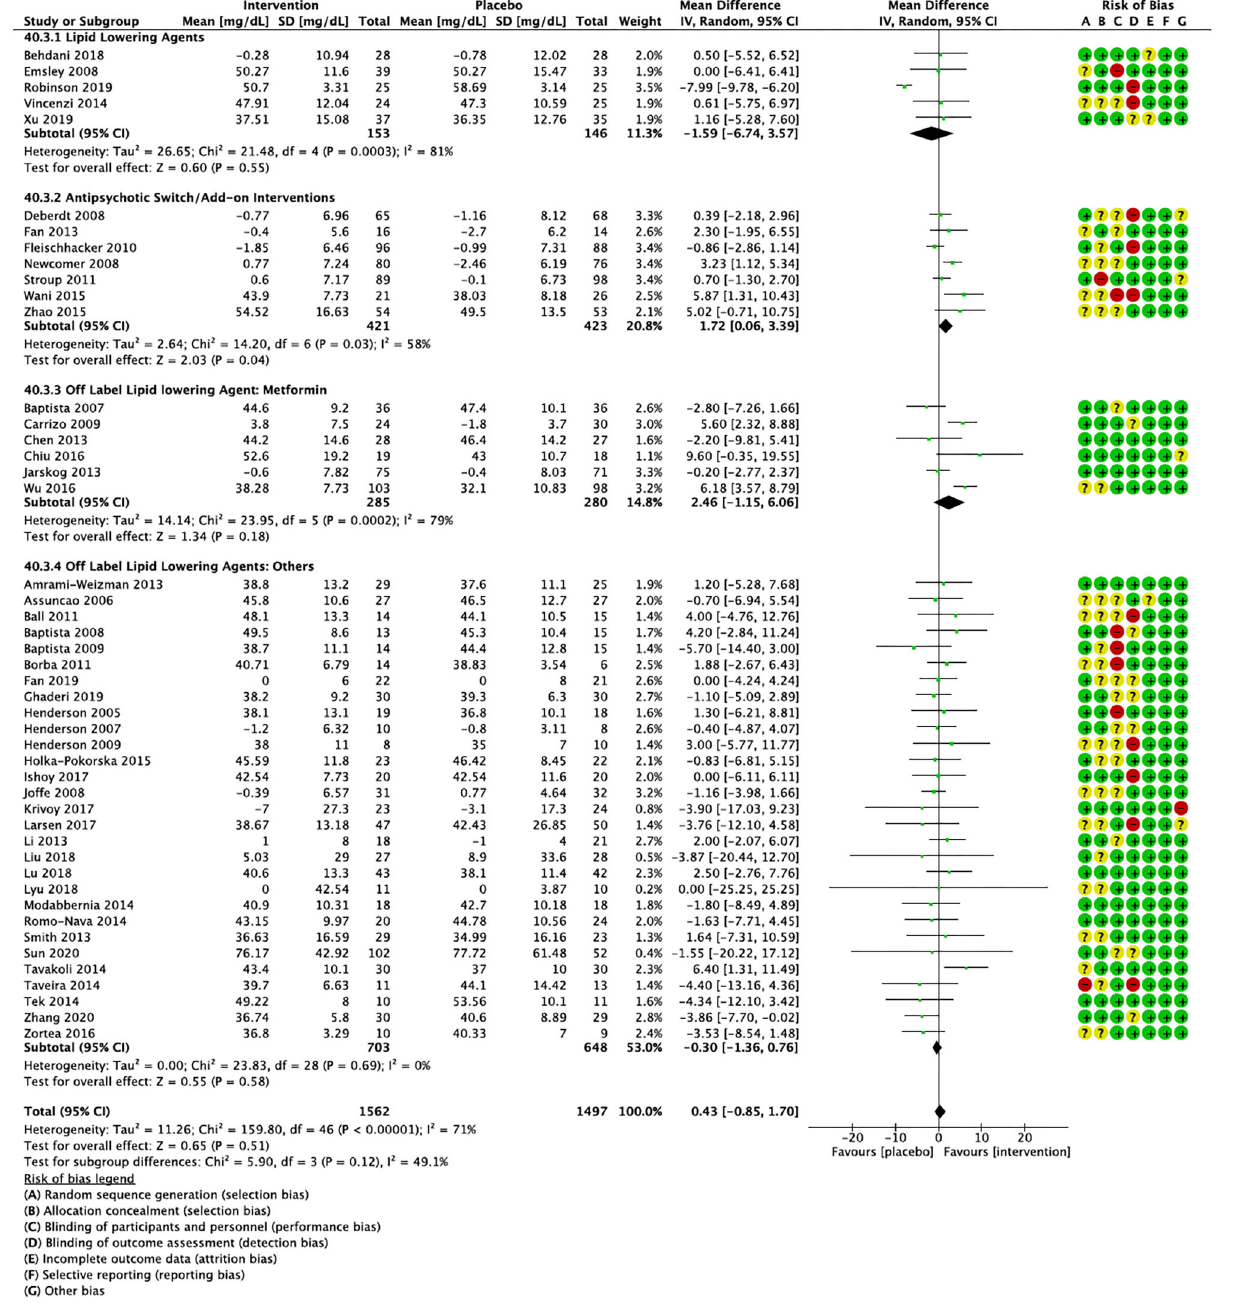
( Figure 6 ; N = 3, n = 419; WMD = − 14.40 mg/dL; CI: − 26.51, − 2.28; p = 0.02; I 2 = 47) compared to placebo. No significant changes were noted for HDL cholesterol ( Figure 3 ; N = 6, n = 565; I 2 = 79) and LDL cholesterol ( Figure 4 ; N = 3, n = 419; I 2 = 89). None of the metformin studies examined VLDL